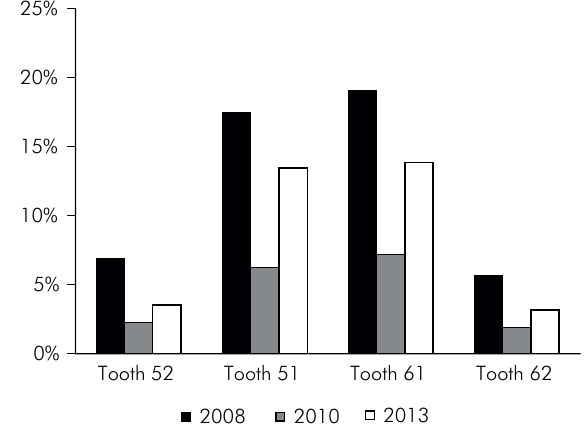
Figure 2. Prevalence of traumatic crown injuries in each year according the